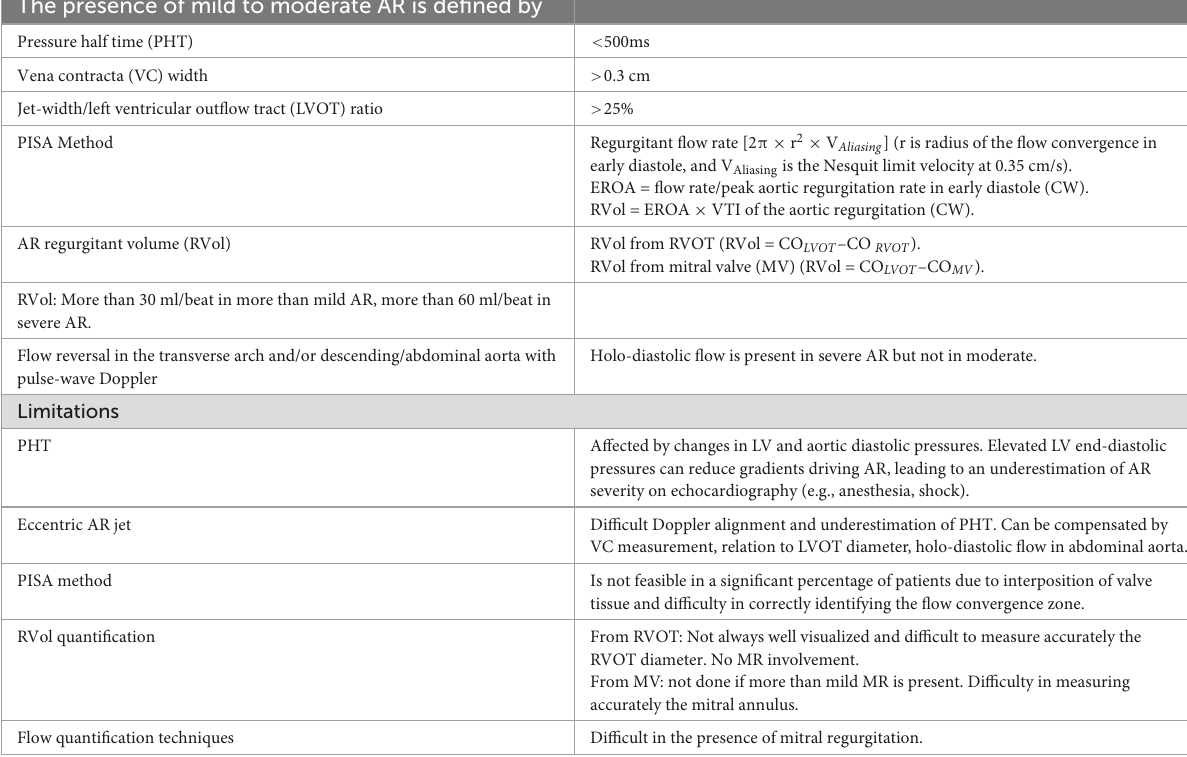
RVol: More than 30 ml/beat in more than mild AR, more than 60 ml/beat in severe